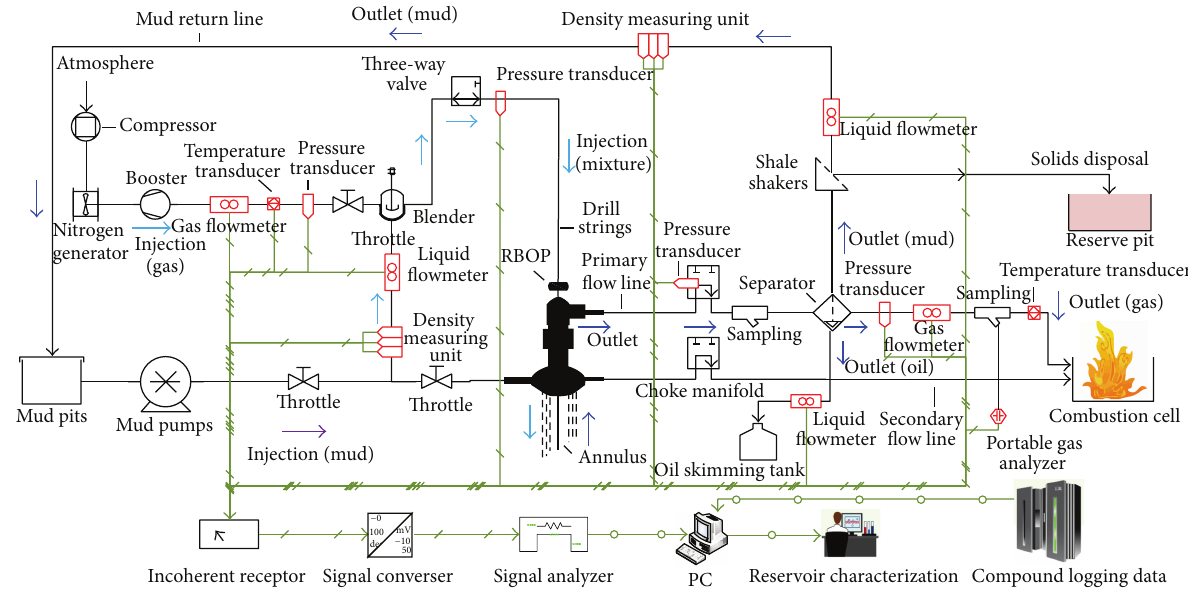
Figure 1: A schematic of the placement of the real-time data monitoring system for aerated drilling.